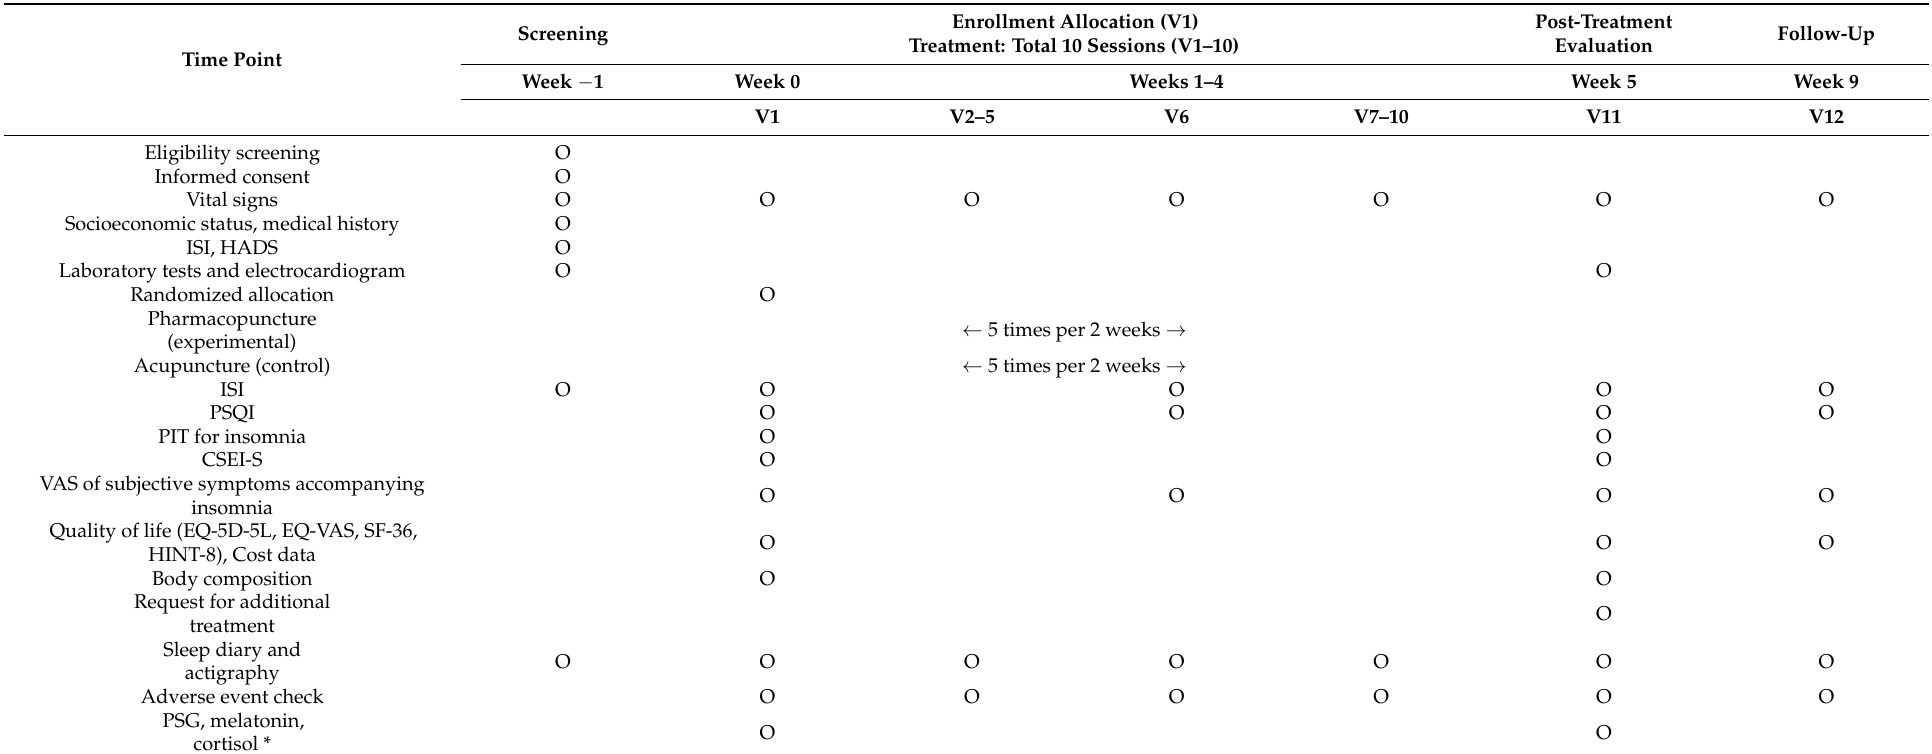
Table 1. Schedule of enrollment, intervention, and